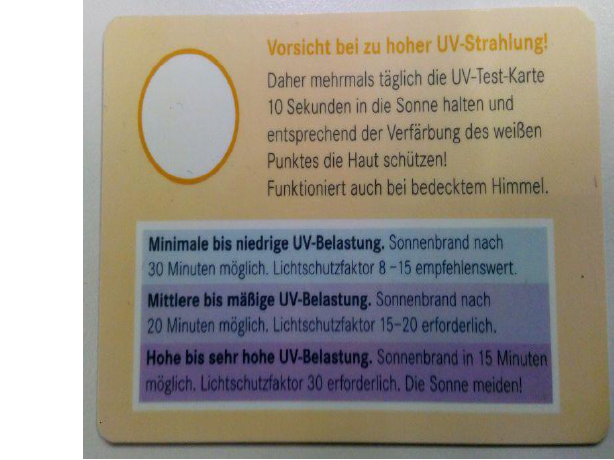
Figure 6. Examples of indicator cards (photochromic) from the 1980s and 1990s worn like a wristwatch (left) or designed like a credit